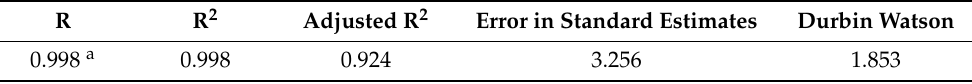
Table A1. Model summary b .